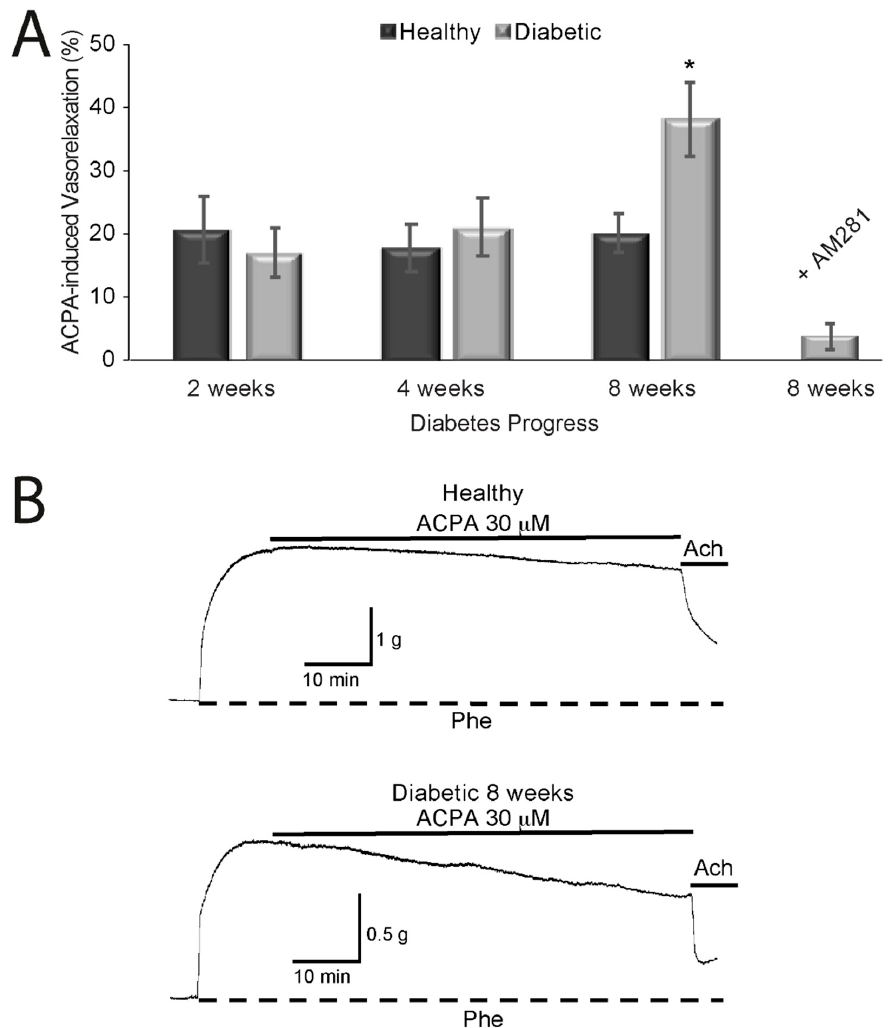
Figure 1. Vasorelaxant effect of arachidonylcyclopropylamide (ACPA) on healthy and diabetic rat aortic rings. ( A ). Summary of the vasorelaxant effect induced by ACPA at different times after diabetes induction. Dark bars correspond to healthy rats, and gray bars correspond to diabetic rats after 2, 4 or 8 weeks after Streptozotocin administration. The effect of ACPA when cannabinoid receptor type 1 (CB 1 ) receptors were blocked with AM281 is shown in the last gray bar. * Significant ( p < 0.05) change in tension compared to Phe precontraction. ( B ) Isometric tension recording of phenylephrine (Phe) ‐ induced contraction of aortic rings. The top lines indicate exposure to ACPA. Upper trace: vasorelaxant effect of ACPA on a healthy ring. Lower trace: effect of ACPA on a diabetic ring. The relaxation of tension was measured at 60 min of ACPA treatment. The vasorelaxant effect was more pronounced in aortic rings from diabetic rats than those from healthy rats ( n = 5 rats). 2.3. CB 1 Receptor Expression, Phosphorylation Status and Localization in Diabetic Rat Aorta